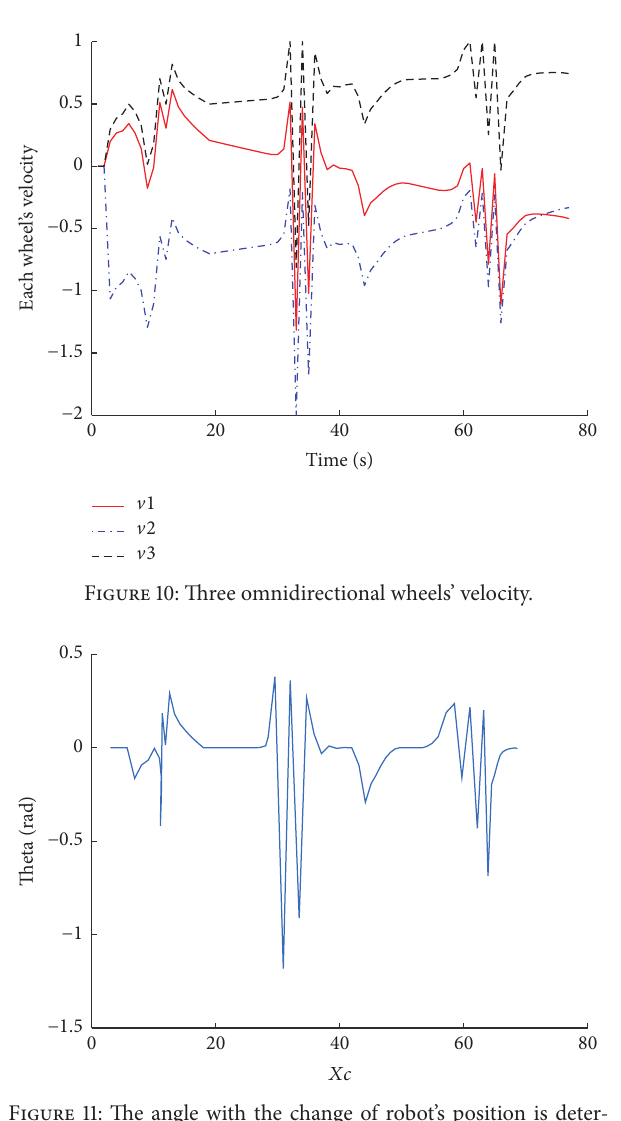
Figure 11: The angle with the change of robot’s position is deter- mined by potential field.